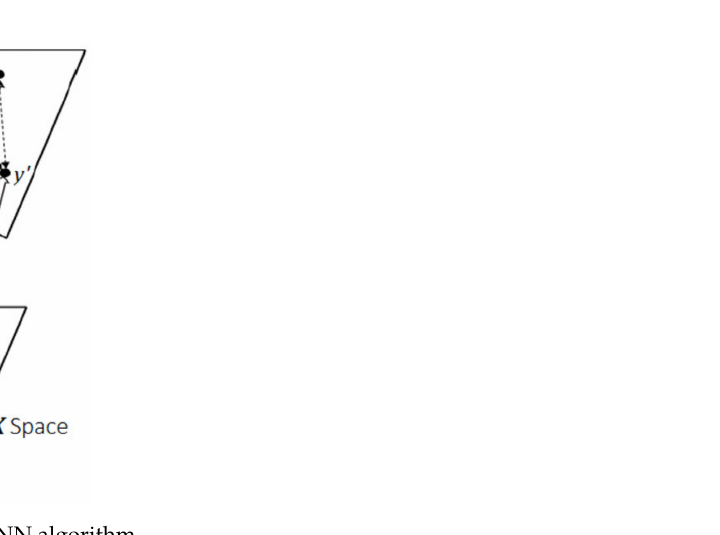
Figure 11. Principle of KNN